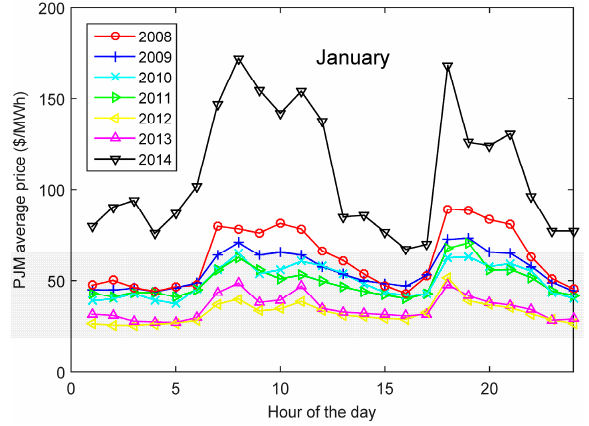
Figure 10. January hourly-based average prices of electricity in RTM, encompassing 7395 nodes.